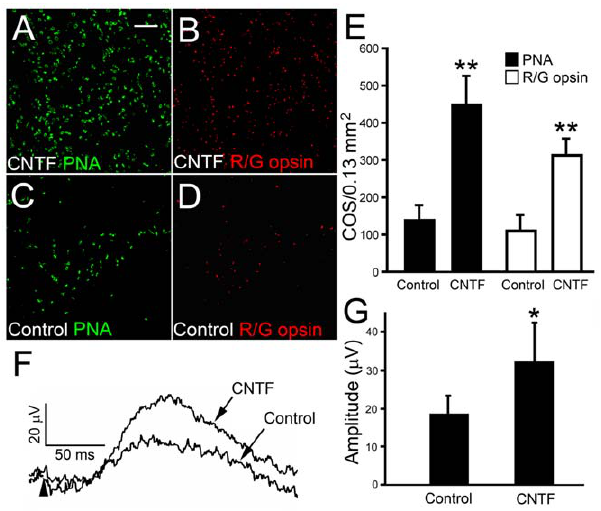
Figure 8. Long-term effects of sustained delivery of CNTF. Eyes of S334ter-3 rats were implanted with microdevices containing CNTF- secreting cells or parental cells at PD 20 and harvested on PD 160. Whole-mounted retinas (superior regions) were stained with PNA or antibodies against red/green opsin. PNA or red/green opsin positive cells are more in the retinas treated with CNTF devices (A and B than the fellow control retinas (C and D). Quantitative analysis of PNA or red/ green positive cells in the superior retina showed significantly more cells in CNTF-treated retinas (446 6 80 and 310 6 46, respectively) than the controls (141 6 40 and 108 6 46, respectively) (E, mean 6 SD, n=3). Cone ERGs were recorded at PD 135 from eyes implanted at PD 20 with CNTF secreting or control devices. Representative b-waves from CNTF treated and control eyes are shown in panel F. The onset of flash is indicated by an arrowhead. The amplitudes of b-waves from CNTF treated retinas (32.46 6 10.02 m V) is significantly larger than from control retinas (17.70 6 4.78 m V) (G, mean 6 SD, n=3). Asterisk indicates P , 0.05; double-asterisk indicates P , 0.01 (Student t -test). Scale bar: 50 m